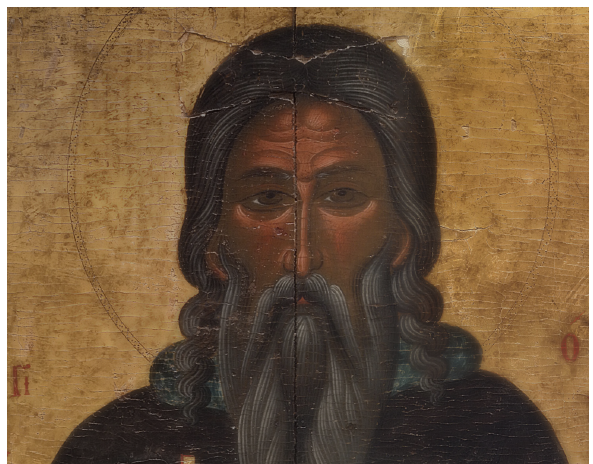
Figure 3: Close up of the textured model of the Icon of Saint Neophytos